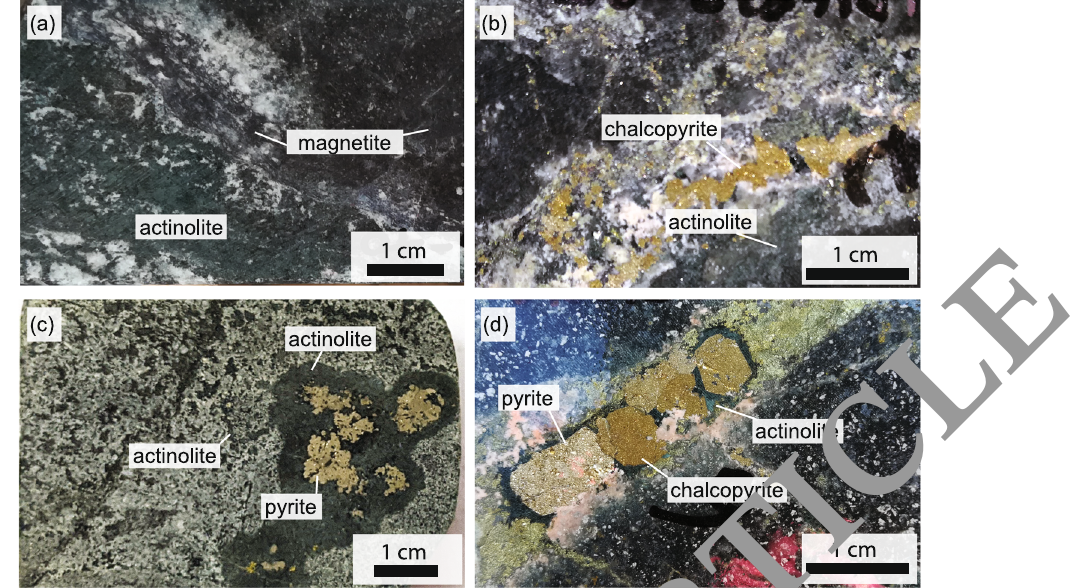
Fig. 1 Drill core samples showing actinolite associated with both the main Cu mineralization and the early Fe stage at the Candelaria deposit. Image ( a ) corresponds to sample LD1687-70 (depth 1109.5 m) where actinolite is observed as a pervasive alteration together with magnetite, but with no Cu sul fi des. Image ( b ) corresponds to sample LD1687-35 (depth 585.12 m) where actinolite is observed close to Cu-sul fi de mineralization but not clearly coeval. Image ( c ) shows sample LD1687-63 (depth 1001.3 m) where actinolite is observed fi nely disseminated in the host rock and in a cumulate surrounding pyrite. Image ( d ) shows a chalcopyrite-pyrite-actinolite vein crosscutting the andesite host rock with pervasive actinolite-magnetite alteration (sample LD1687-13